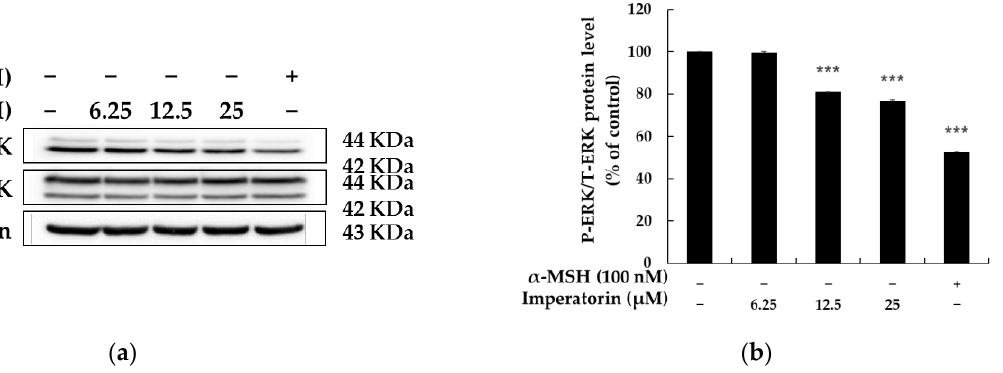
Figure 6. The effects on the phosphorylation level of ERK in B16F10 melanoma cells when the cells were treated with imperatorin (6.25, 12.5, and 25 μM) for 3 h: ( a ) Western blotting results; ( b ) protein levels of P-ERK/ERK. Β -Actin was used as a loading control. The results are presented as the mean ± SD from three independent measurements using ImageJ software. *** p < 0.001 vs. the untreated control group.